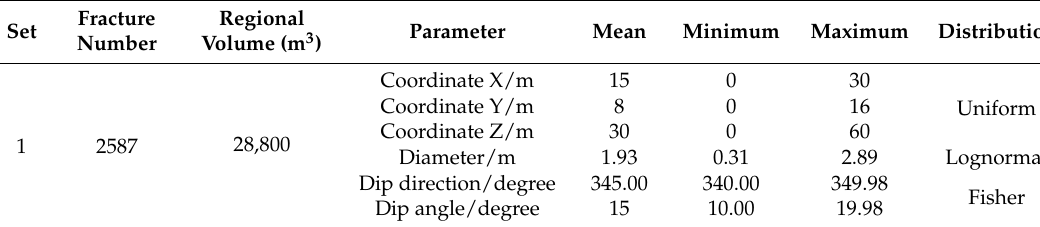
Table 1. Statistical results of fracture parameters.